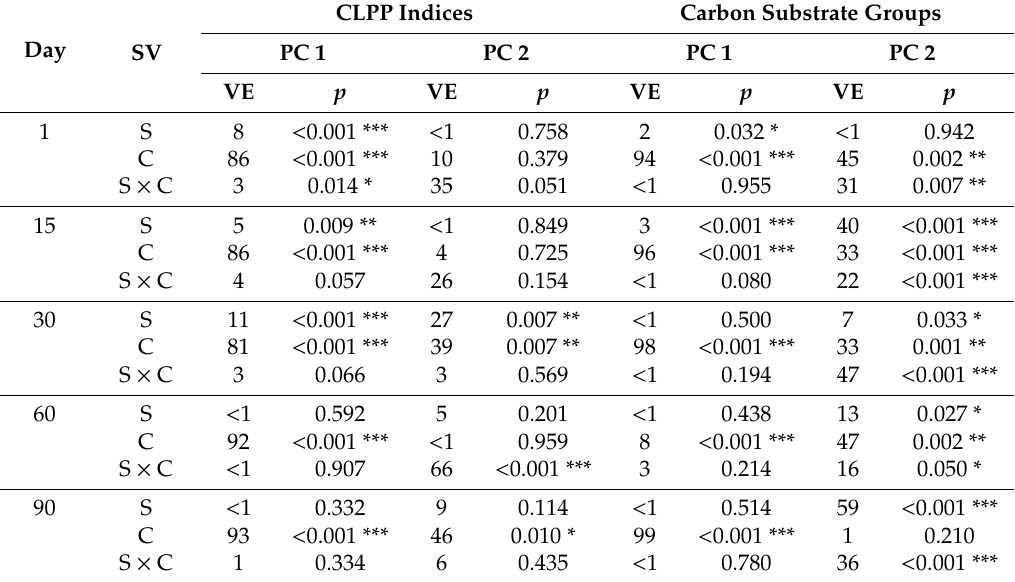
Table 4. Results of the two-way MANOVA for the PC1 and PC2 based on the CLPP indices and carbon substrate groups.